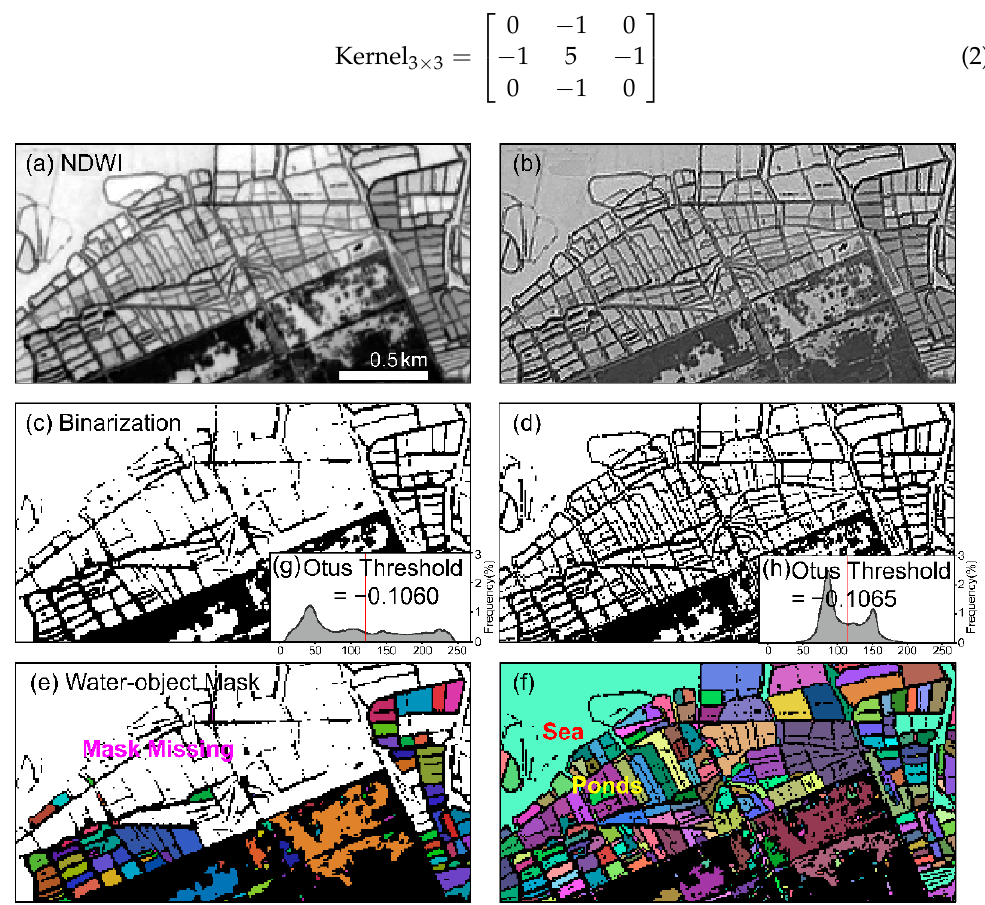
Figure 3. Water-object production process: ( a ) NDWI image, ( b ) Sharpened NDWI image. ( c , d ) are ( a , b ) obtained after adaptive binarization segmentation by Otsu’s method. ( g , h ) are the double- peak gray value distribution diagrams of ( a , b ), and the red line is the adaptive binarization threshold. ( e , f ) are water objects, each color represents an object. The water object produced by NDWI imagery is partially missing. The water object produced by Sharpened NDWI imagery has suitable separation and coverage.